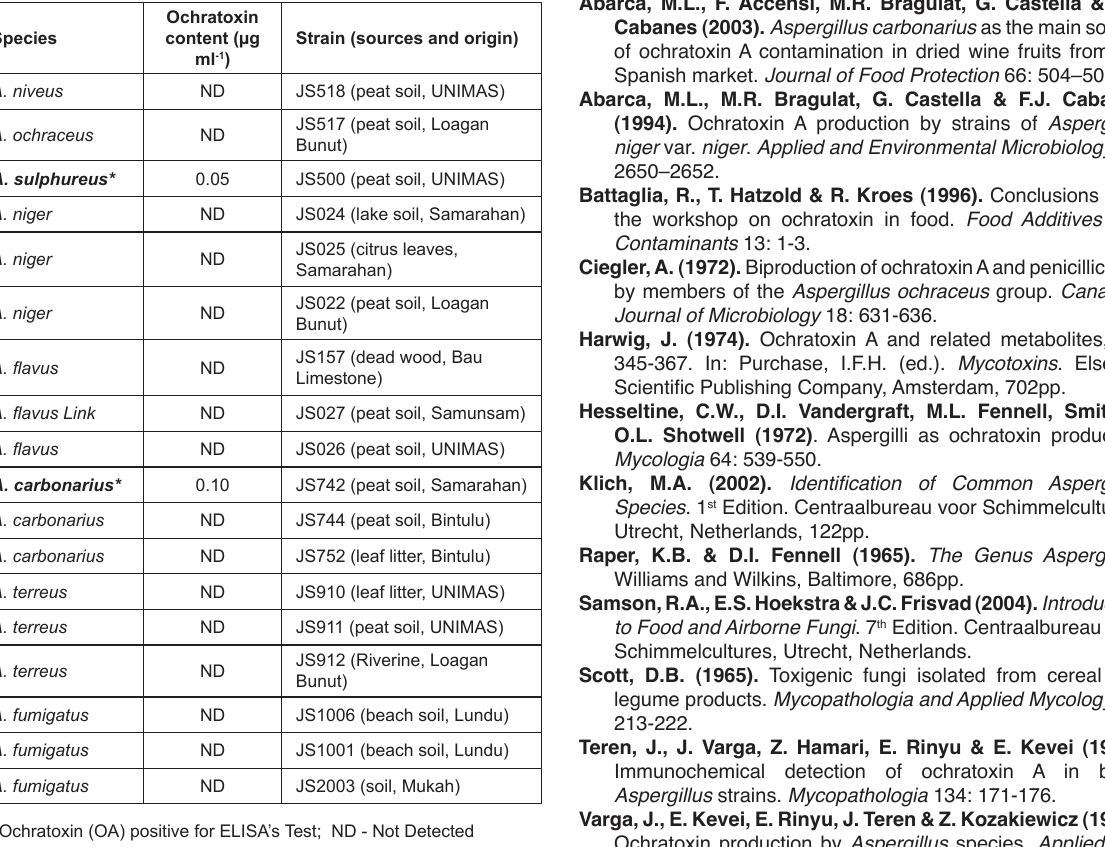
* - Ochratoxin (OA) positive for ELISA’s Test; ND - Not